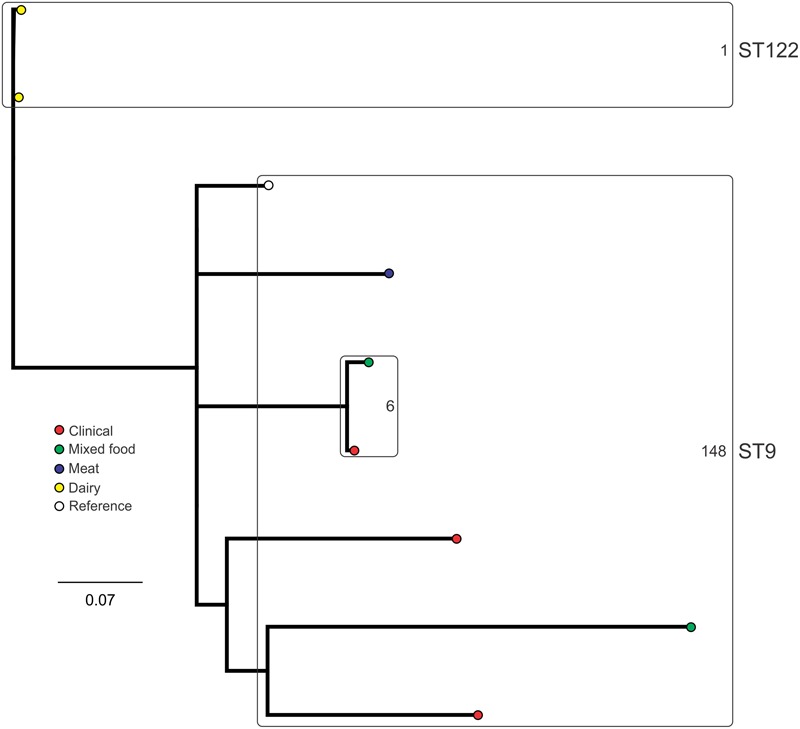
Phylogenetic analysis of serogroup IIC core genome SNPs. STs containing multiple isolates are indicated by labeled rounded rectangles (the CC or ST is labeled on the outside right, and the number of SNPs is indicated by the number on the inside right of the rectangle).